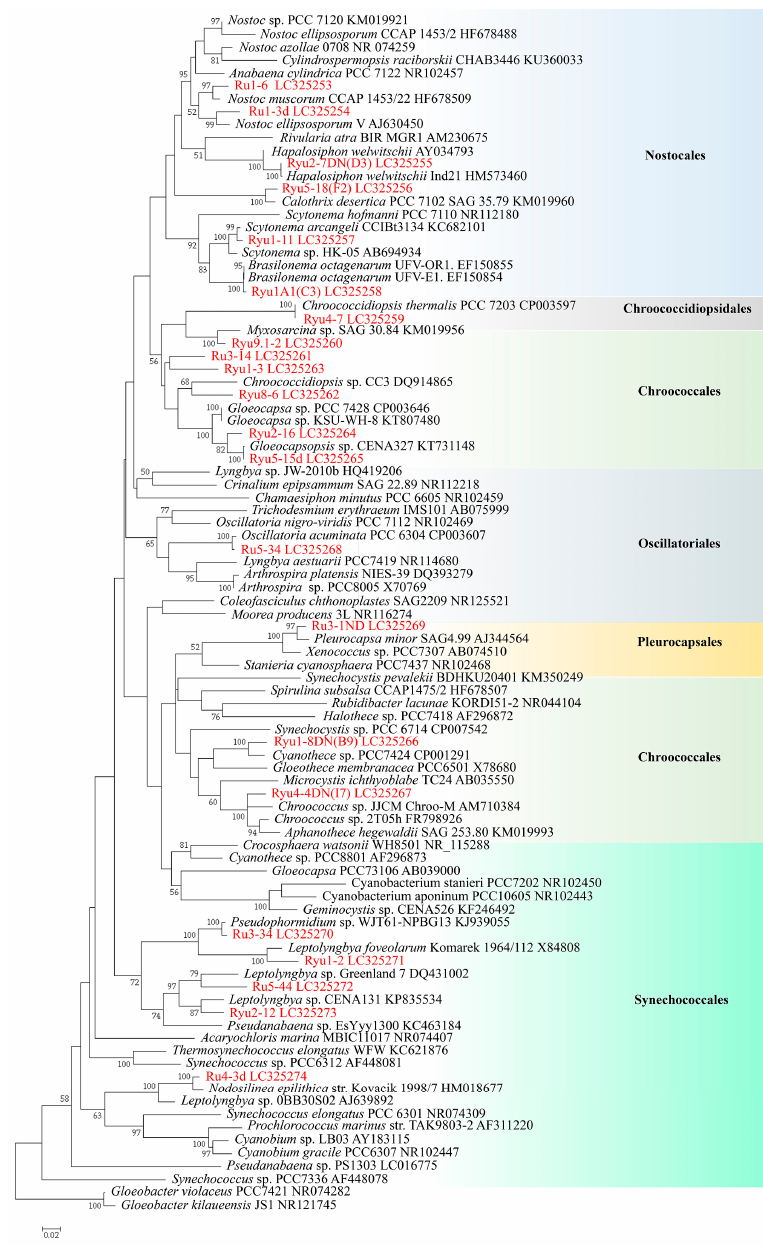
Figure 4. Maximum likelihood tree based on 16S rDNA gene sequences. The General Time Reversible-parameter model (GTR+G+I) was used, with the outgroups selected as Gloeobacter kilaueensis (NR121745) and Gloeobacter violaceus PCC 7421 (NR_074282). Bootstrap values were tested 1000 times using the rapid bootstrap option ( ≥ 50%).